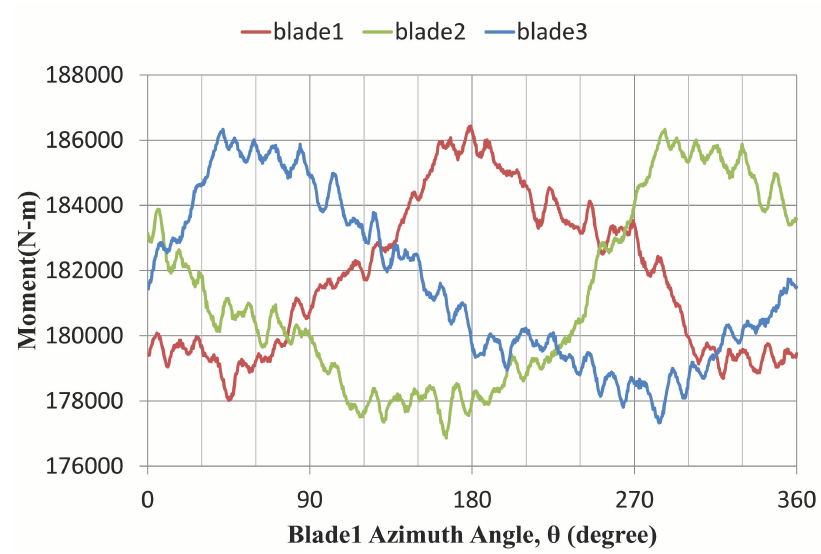
Figure 12. Blade torque vs. azimuth angle.